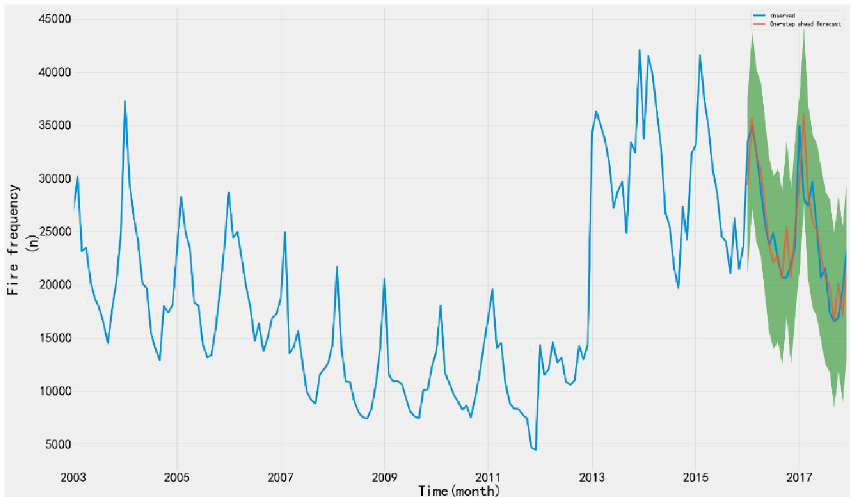
Fig 7. Time series of fire frequency fitting by the Optimization of SARIMA model. The optimized SARIMA model is applied to predict the fire data from January 2018 to December 2019, and the prediction results are shown in Fig 8. Compared with the prediction results of the original model, the optimized model shows that the fire frequency predicted by the optimized SARIMA model is lower than the original model. Moreover, the prediction data shows a downward trend year by year, which is consistent with the trend of the fire frequency.